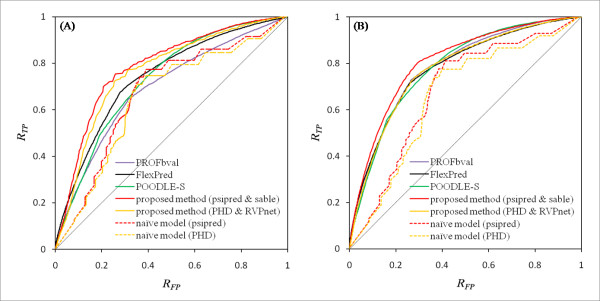
Receiver Operator Characteristic (ROC) curves. The ROC curves for the proposed method, naïve model, and three published predictors for (A) internal motion and (B) external motion are shown. The red and orange lines respectively signify proposed methods that implemented psipred and sable, and PHD and RVPnet. Similarly, the red and orange dashed lines respectively show the naïve model implemented with psipred and PHD. The purple, green, and black lines respectively show PROFbval, POODLE-S, and FlexPred. The threshold value was set to 0. The vertical and horizontal axes represent the true positive rate and false positive rate, as calculated in the Assessment of the Methods section.